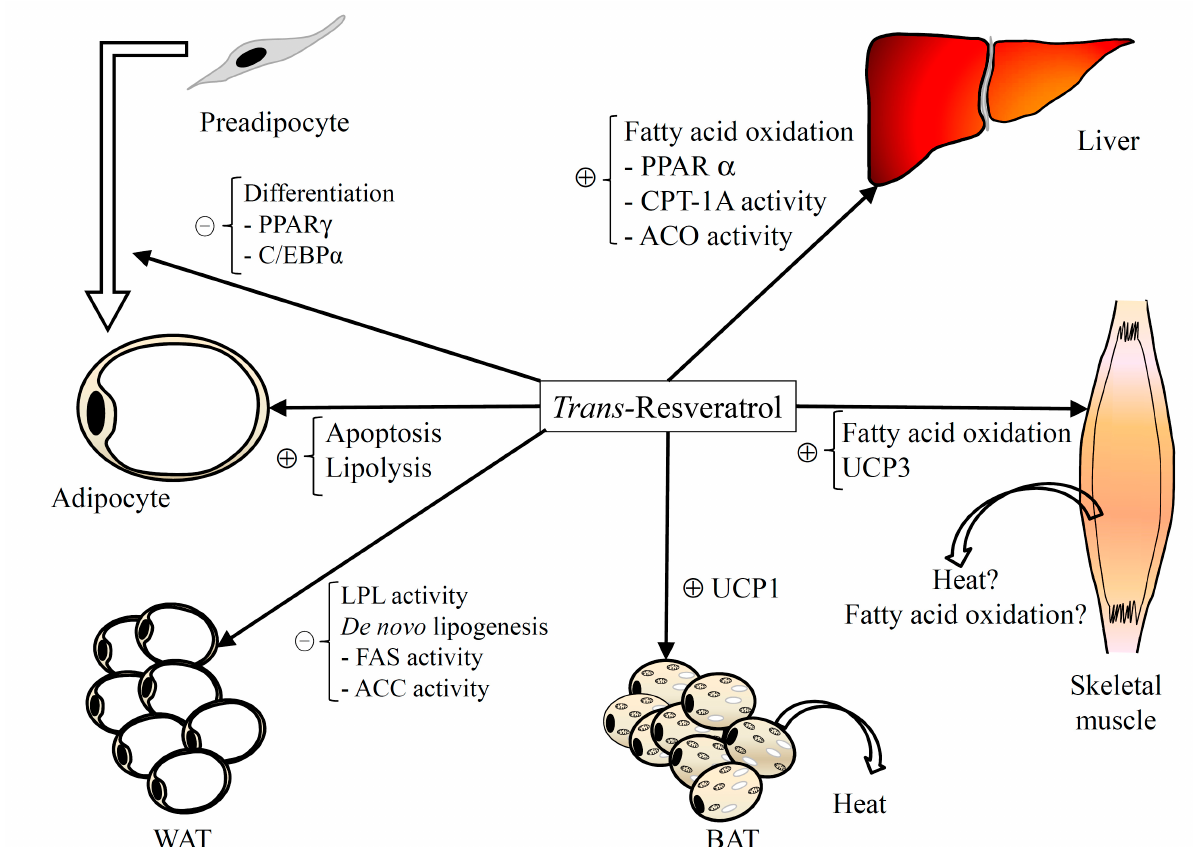
Figure 1. Major mechanisms involved in the anti-obesogenic effect of resveratrol. ACC: Acetyl-CoA carboxylase; ACO: Acyl-CoA oxidase; BAT: Brown adipose tissue; C/EBP: CCAAT/enhancer-binding protein; CPT: Carnitine palmitoyltransferase; FASN: Fatty acid synthase; LPL: Lipoprotein lipase; PPAR: Peroxisome proliferator-activated receptor; UCP: Uncoupling protein; WAT: White adipose